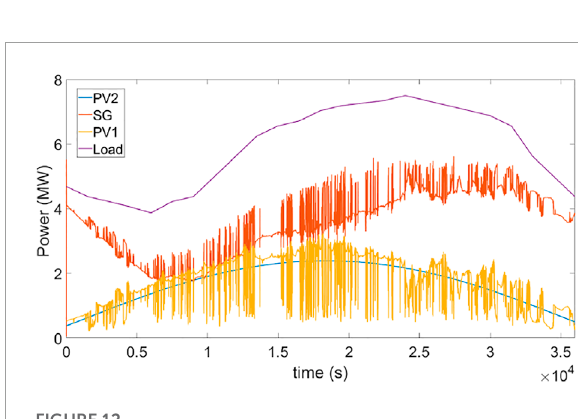
Algorithm 1 —Local curtailment—Pseudo Code depicts the control strategy. The DRR is comparable to LC control. It uses the determined forecast result at PV1 but reserves power at a stable PV station.